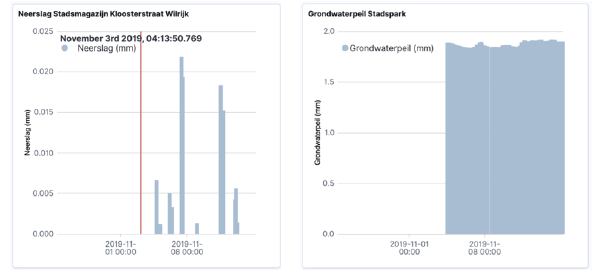
Figure 4. The initial Antwerp dashboard included several